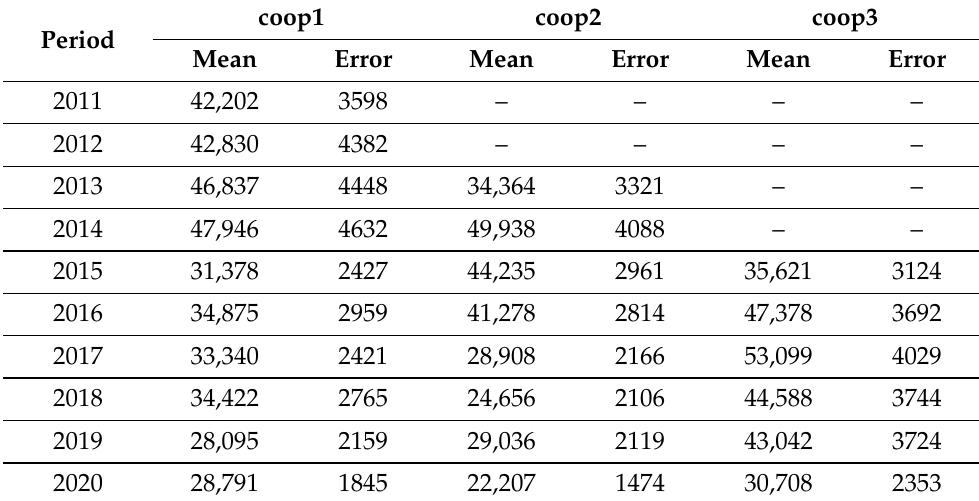
Table 1. Local means and standard errors of